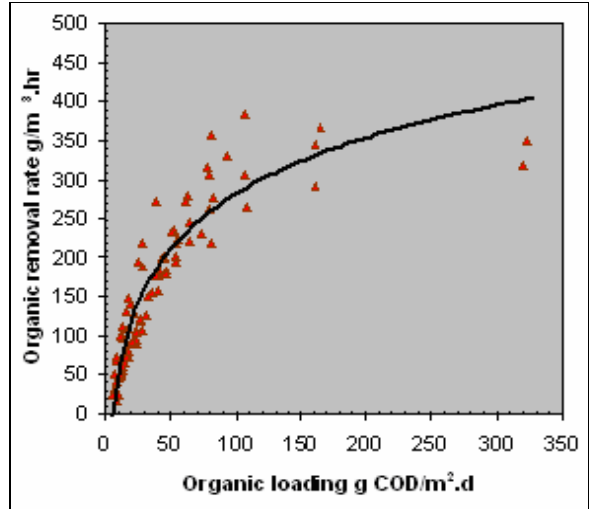
Figure 19: Effect of total applied organic loading on organic removal